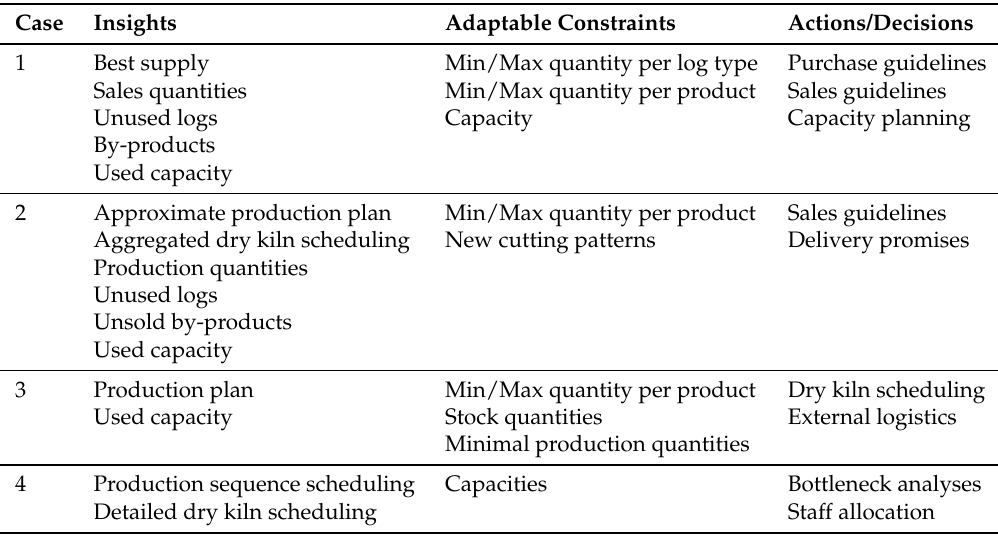
Table 2. Summary of the insights, adaptable constraints and supported actions, and decisions for the four application cases introduced in Section